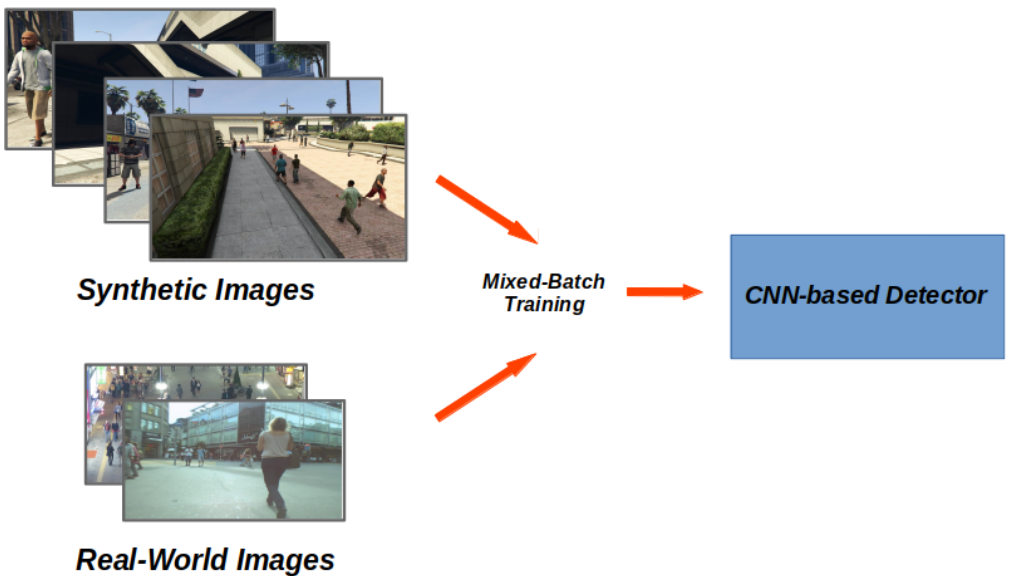
Figure 5. Overview of the second domain adaptation technique. We mitigate the Synthetic2Real domain shift in a single-step training procedure, employing mixed batches containing both synthetic and real images at the same